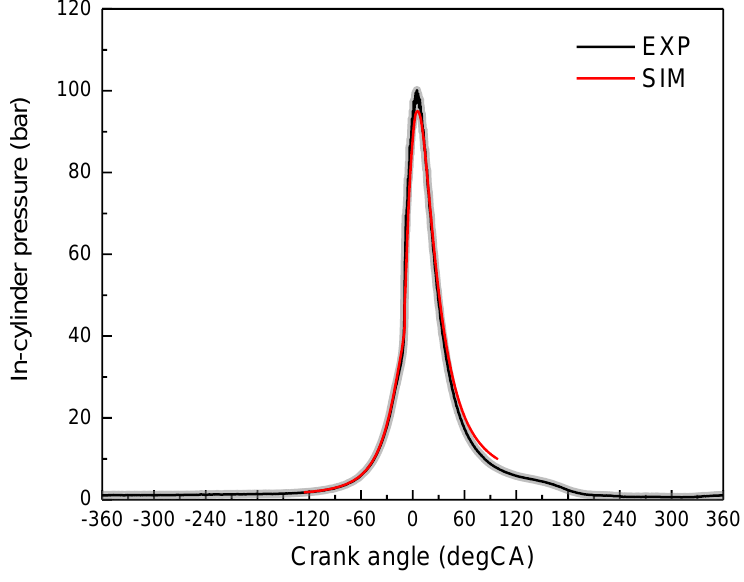
Figure 8. Comparison of numerical and experimental pressure with an error bar of 2% at an altitude